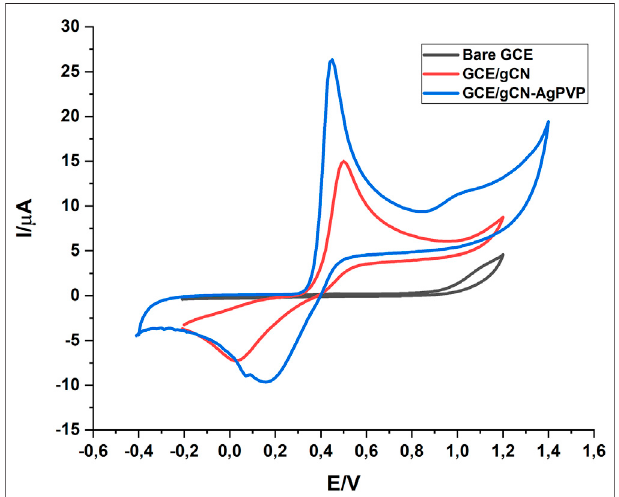
FIGURE 5 | CV characterisation of Bare GCE, gCN and Gcn-AgPVP in 0,1 M PBS, pH 6,1.